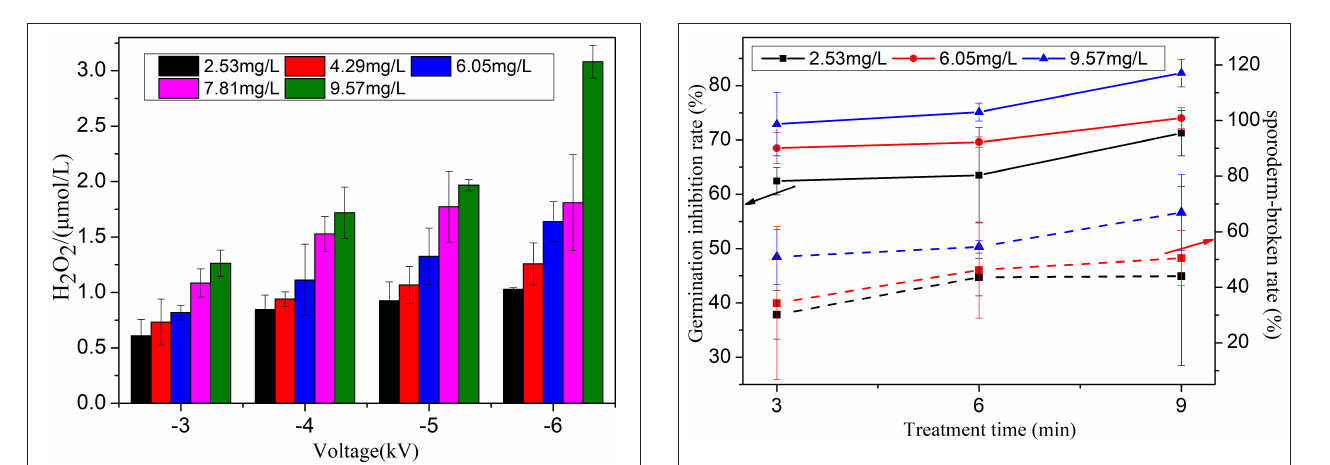
FIGURE 12 | Variation of the H 2 O 2 content with the water content.